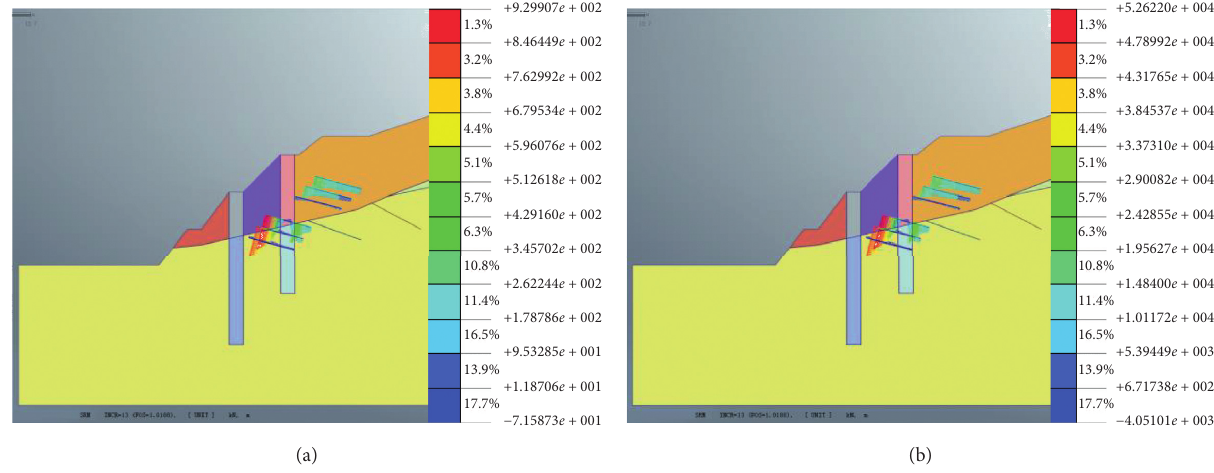
Figure 12: Cloud diagrams of the prestressed anchor cable considering steady-state seepage: (a) axial force; (b) axial stress.